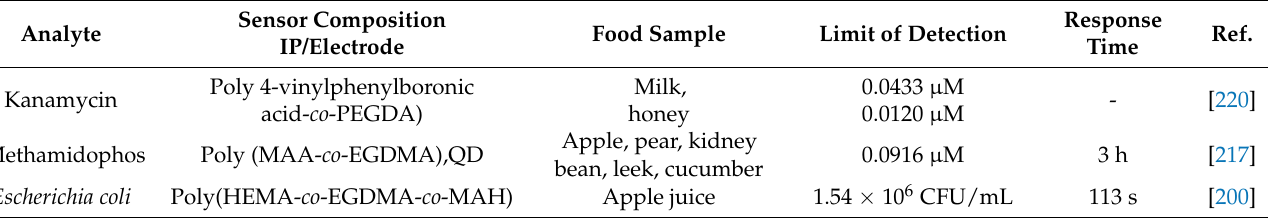
Table 7. Imprinted polymer-optical sensors for food